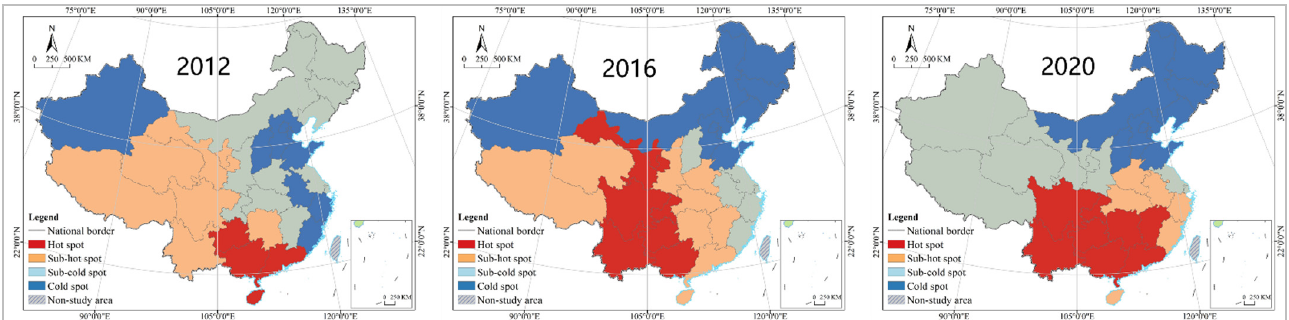
Figure 16. Analysis of spatial cold- and hot-spots of per unit area investment.